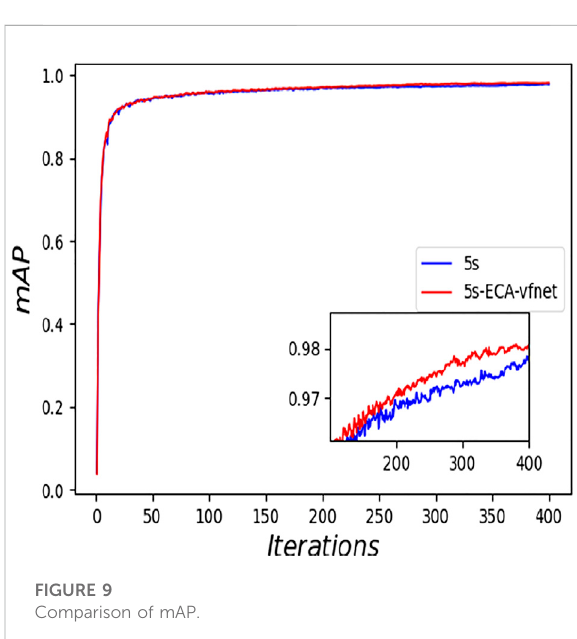
FIGURE 9 Comparison of mAP.